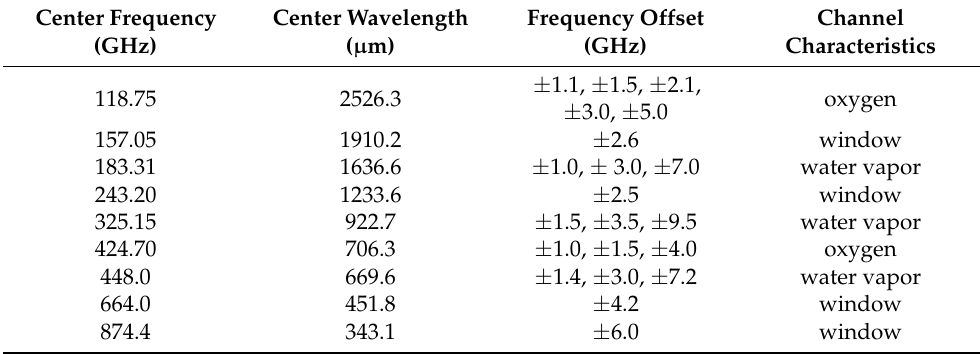
Table 1. Information on the channels in the terahertz